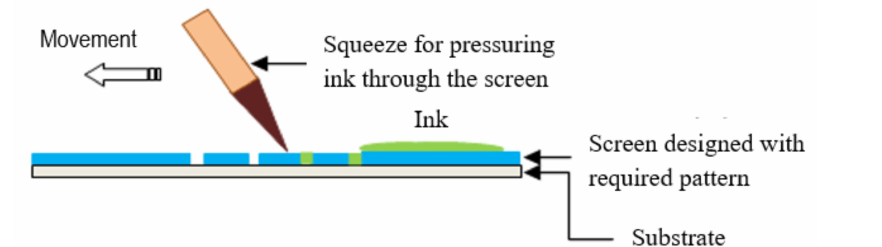
Figure 10. Schematic diagram of screen printing.